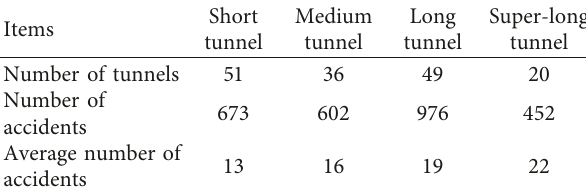
Table 2: Number of accidents and tunnel